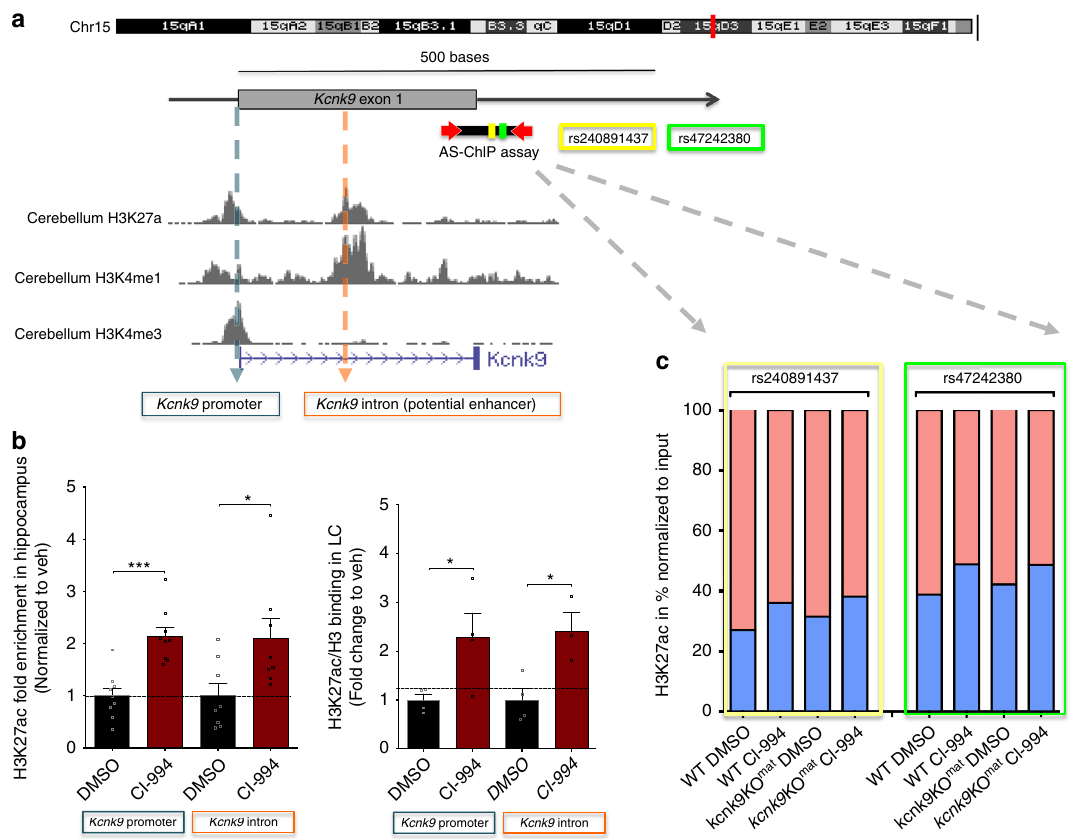
Fig. 6 Treatment with CI-994 affects H3K27 acetylation at the Kcnk9 locus. a Schematic presentation of the Kcnk9 locus on distal mouse chromosome 15. The murine Kcnk9 gene is shown with the corresponding H3K27ac, H3K4me1 and H3K4me3 peaks in mouse cerebellum (UCSC Genome Browser on Mouse July 2007 (NCBI37/mm9) Assembly). b Increased deposition of H3K27ac marks at the promoter and intronic region of Kcnk9 in hippocampus and locus coeruleus (LC) in Kcnk9 KO mat mice following treatment with CI-994 (normalized to veh). Hippocampus (left): in Kcnk9 promoter, DMSO ( n = 9) vs. CI-994 ( n = 9), P = 0.0001; in Kcnk9 intron, DMSO ( n = 8) vs. CI-994 ( n = 8), P = 0.0270. LC (right) in Kcnk9 promoter, DMSO ( n = 4) vs. CI-994 ( n